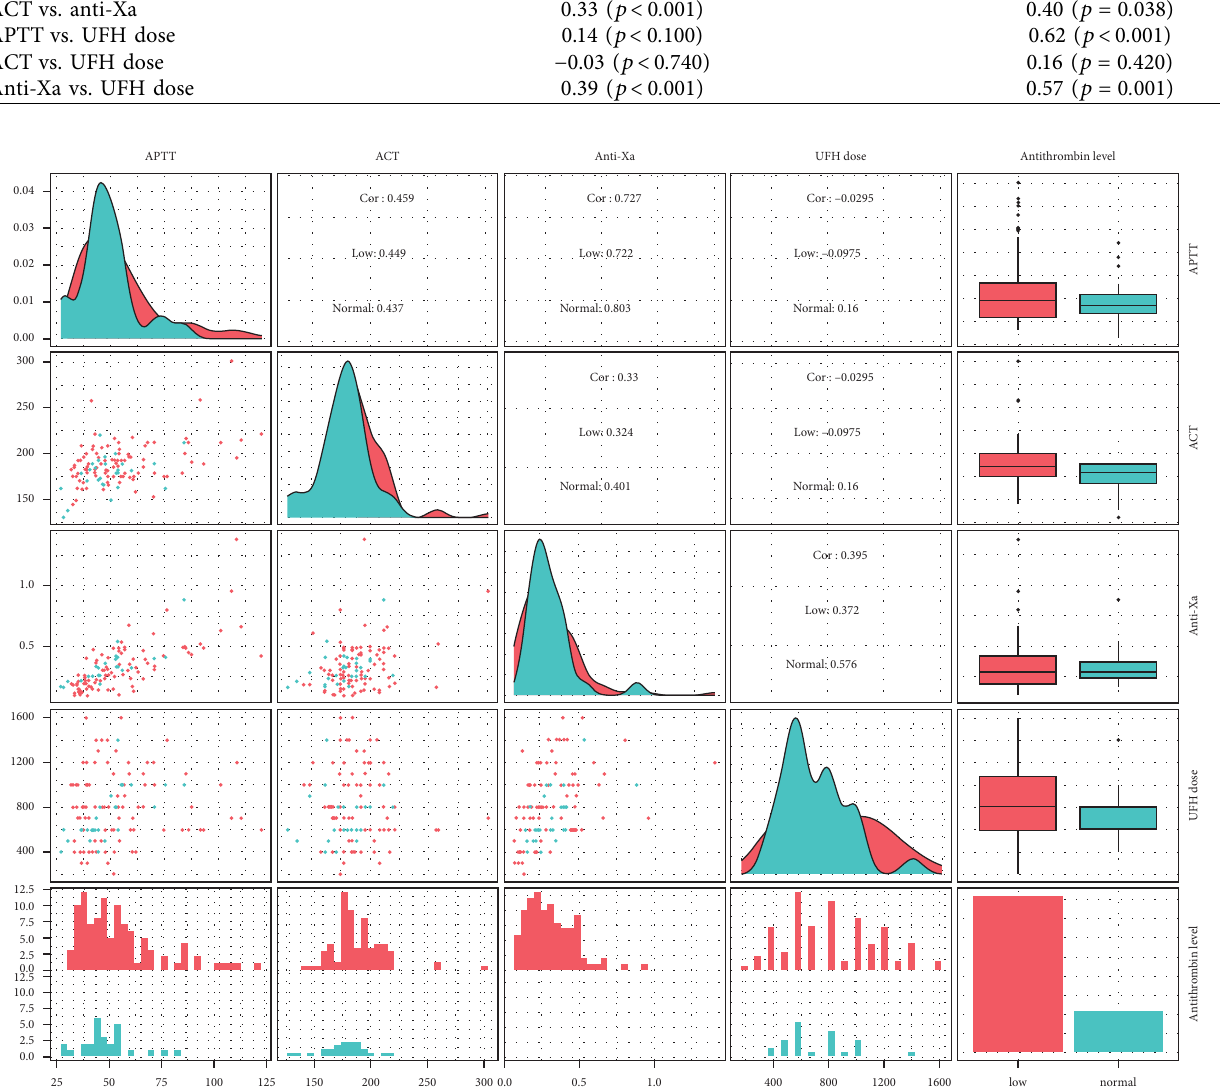
Table 2: Correlation between ACT, APTT, anti-Xa values, and concurrent heparin dosing. Correlation coefficient spearman All Normal antithrombin level APTT vs.